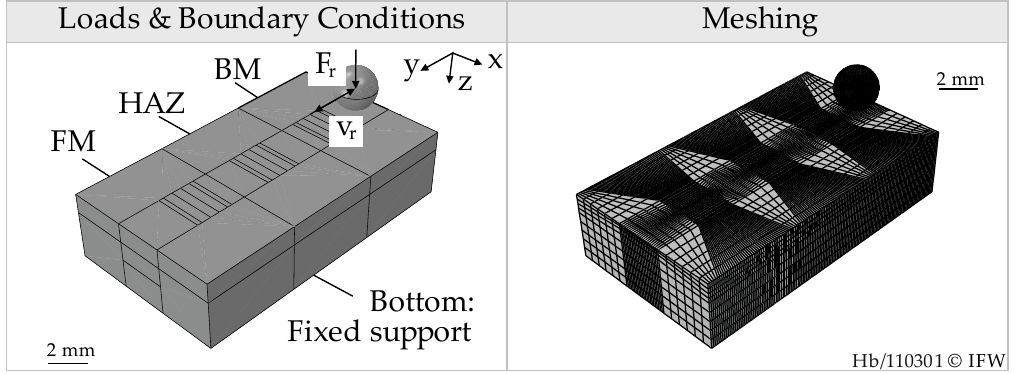
Figure 5. Loads, boundary conditions, and meshing of deep rolling FE-model.